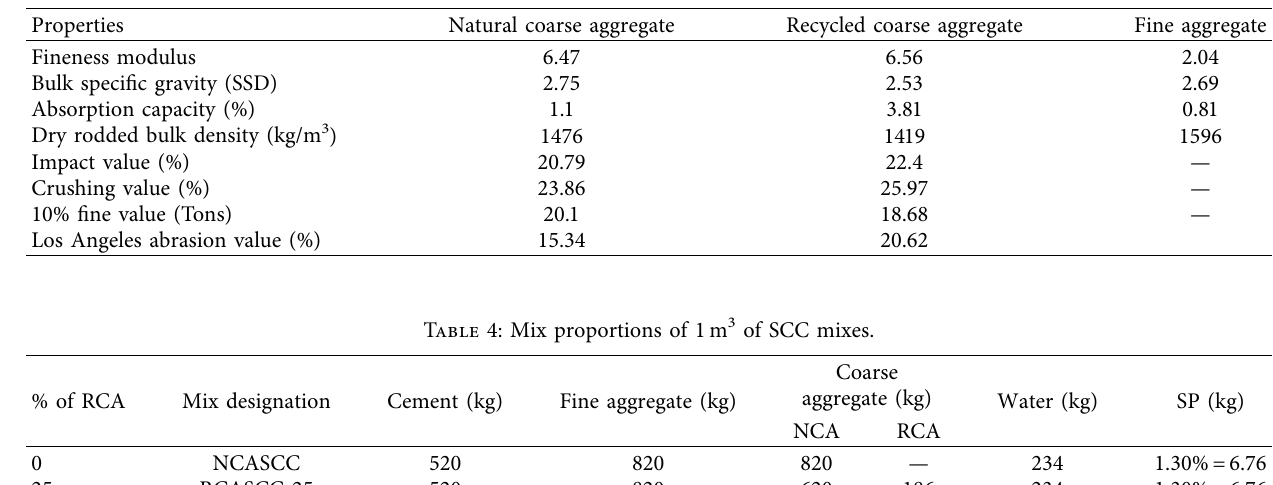
Figure 1: Gradation curves of aggregates. Table 3: Properties of aggregates.